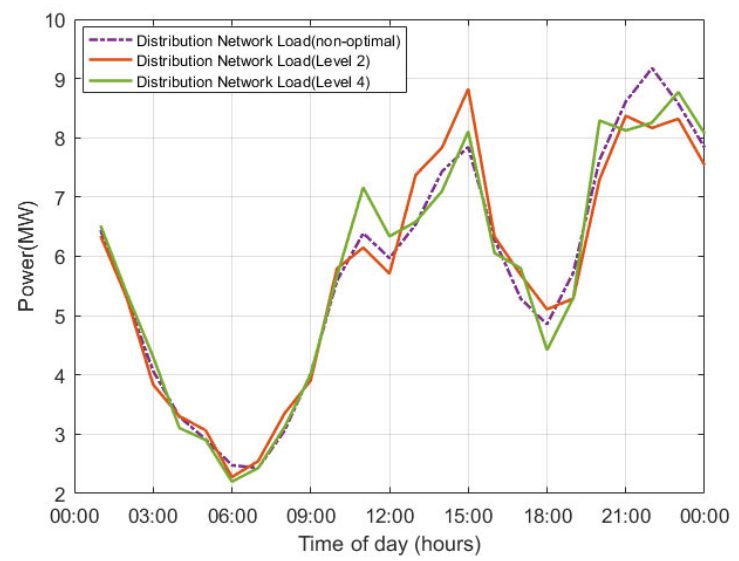
Figure 19. Active distribution network load before and after the execution of the optimization levels 2 and 4.